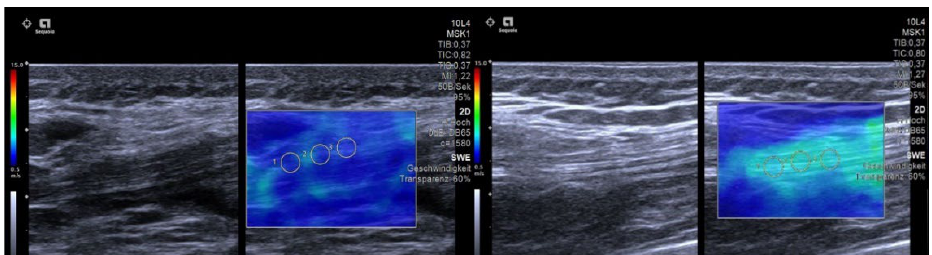
Figure 4. Exemplary images of the right quadriceps tendon in an adolescent soccer athlete ( left ) and an adult athlete ( right ). As depicted by the color-coded map, SWE showed significant higher shear wave velocity in an adult athlete (green, right image) compared to adolescent athlete (left image). For the quadriceps tendon, a significantly lower stiffness was measured on the right side in our adolescent group. Although approx. 80% of professional soccer athletes are right dominant leg soccer players [28], our data show softer tissue values for the QT and VM on the right side in approx. 70% of adolescent athletes. For adult soccer athletes, our data confirm the prevalence of right leg dominance, with 70% (for the QT) to 80% (for the VM) having stiffer tissue values on the right side. These findings are consistent with a high training load in the adolescent group and might even point to beginning overtraining, as a decrease in tissue stiffness of the quadriceps muscle (vastus medialis, vastus lateralis, and rectus femoris muscle) was reported to be induced by inflammation or muscle swelling